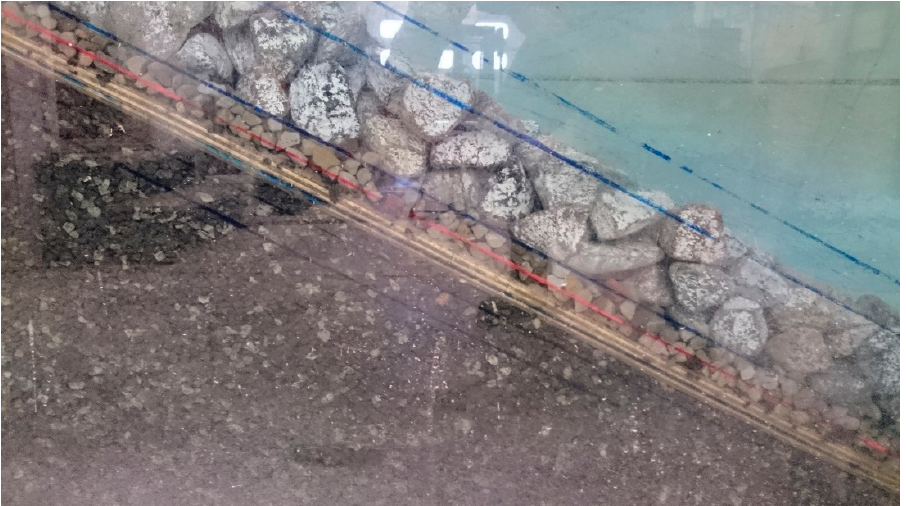
Figure 6. One of the layer compositions with the impermeable core. The figure shows the plywood plate placed on the Class V